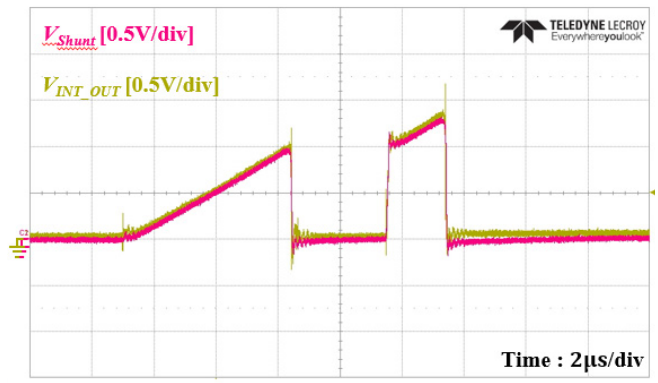
Figure 16. Overall DPT waveform of the shunt resistor and spiral pick-up coil.